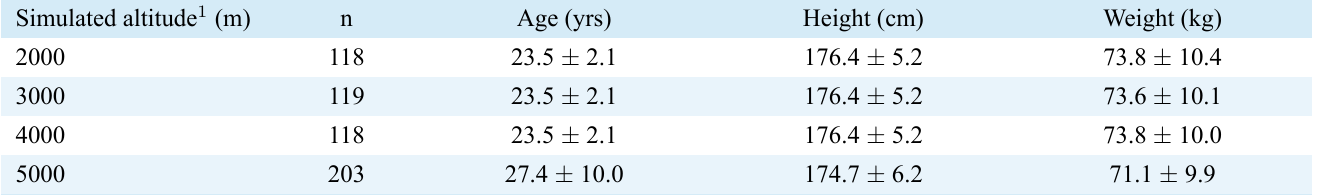
TABLE 2. The sample size and age of subjects were included in the data analysis. Simulated altitude 1 (m)